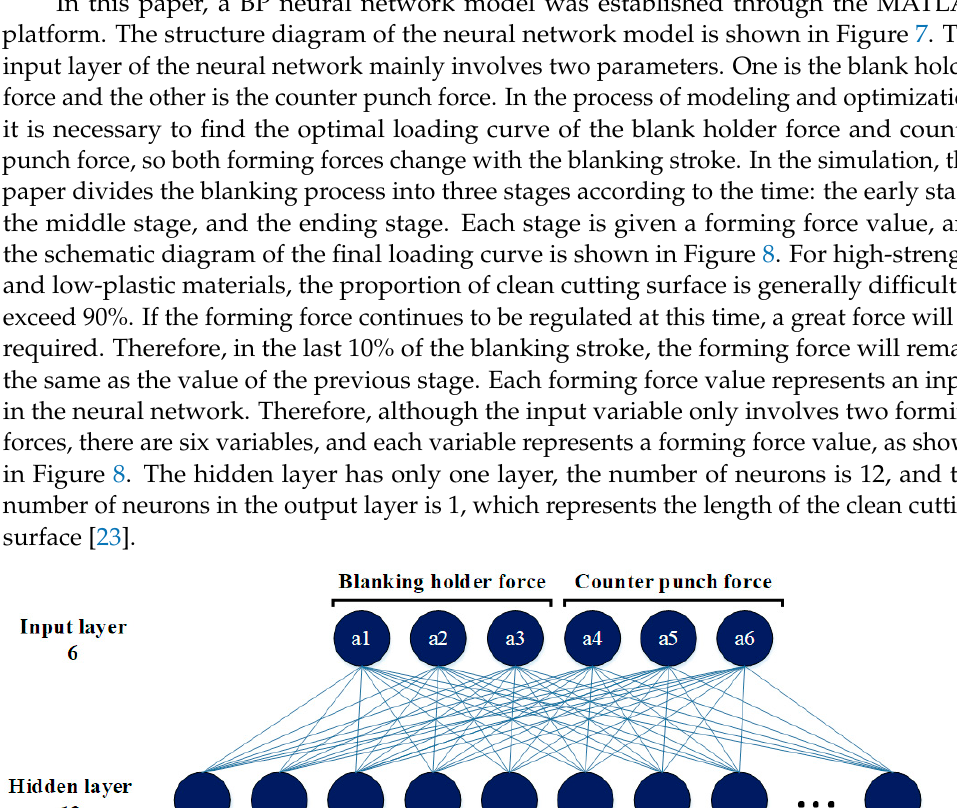
Figure 8. Schematic diagram of forming force variation loading. In order to make the data of the neural network accurate enough, the neural net- work should be trained with a large number of samples before obtaining the relation- ship between the two forming force and the clean cutting surface of the fine-blanking part. As the punching stroke progresses, the forming force value should continue to in- crease, so the force variation finite element simulation is arranged according to the law. Part of the finite element simulation arrangement table is shown in Table 7.